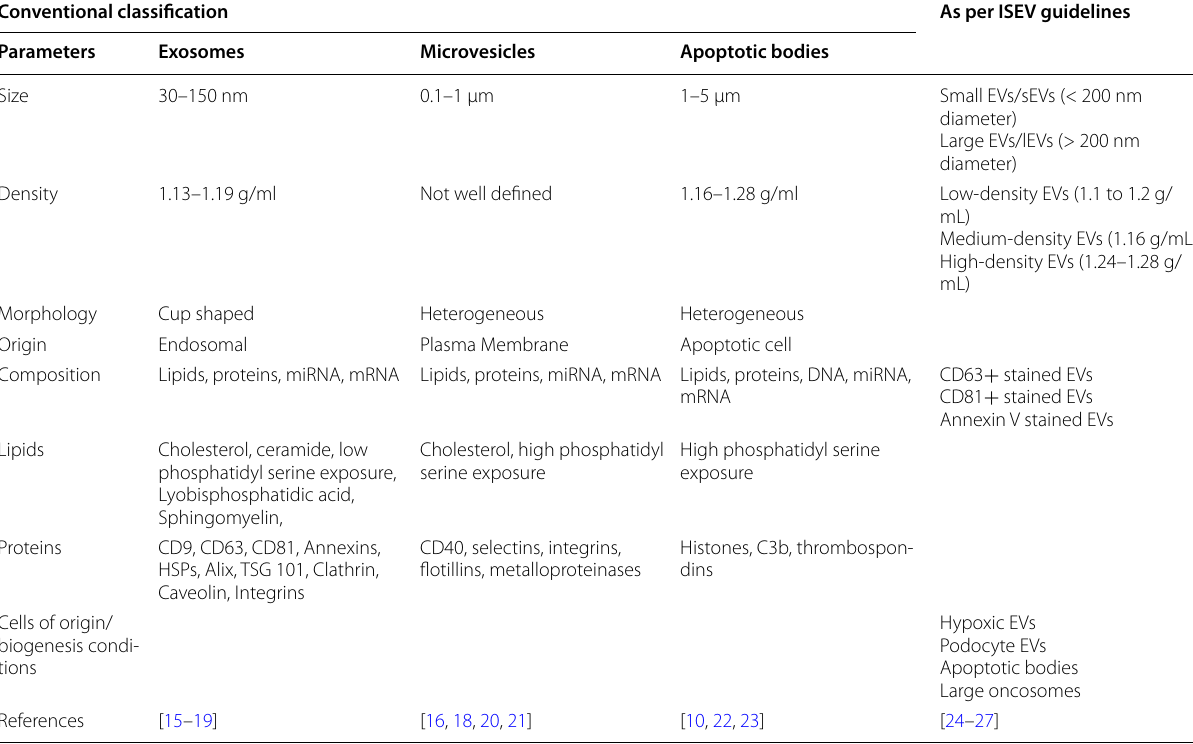
Table 1 Classification of EVs Conventional